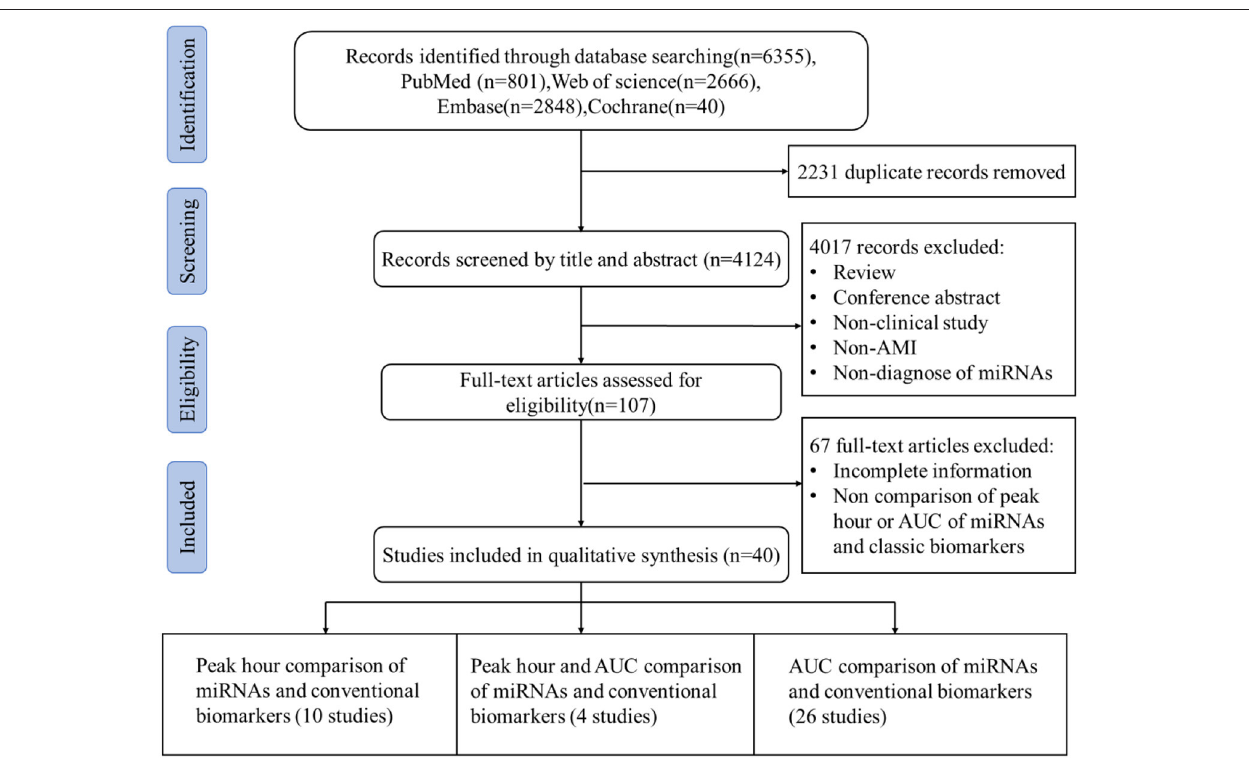
FIGURE 1 | Flow diagram of the literature